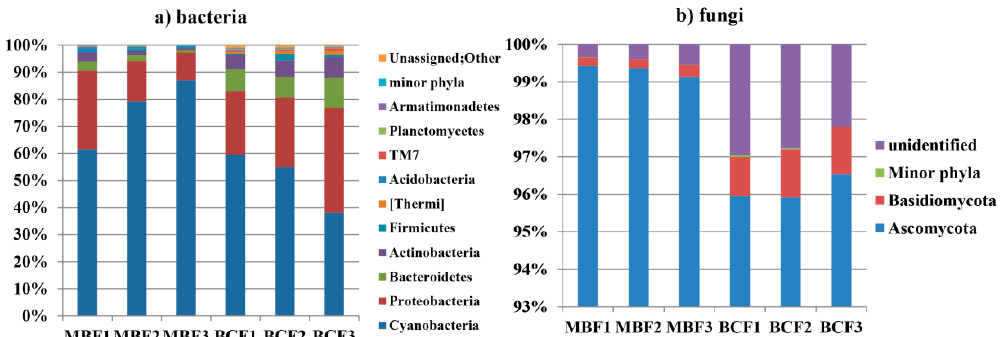
Figure 1. Bacterial and fungal compositions at the phylum level in the moso bamboo leaves. ( a ) Bacterial phyla with an average relative abundance of greater than 0.1%; ( b ) Fungal phyla relative abundance. MBF, adjacent moso bamboo forest; BCF, moso bamboo-chicken farming agroforestry. Table 1. Relative abundances of the dominant bacterial and fungal genera in moso bamboo leaves.